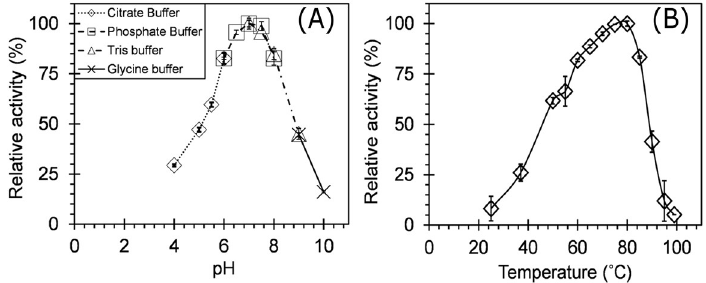
Figure 7. The effect of pH ( A ), and temperature ( B ) on the xylanase activity of Geobacillus sp. strain DUSELR13. The maximum enzyme activity is taken as 100%. The values shown are the mean of triplicate experiments and the error bars represent ± SD of the means with n = 3.